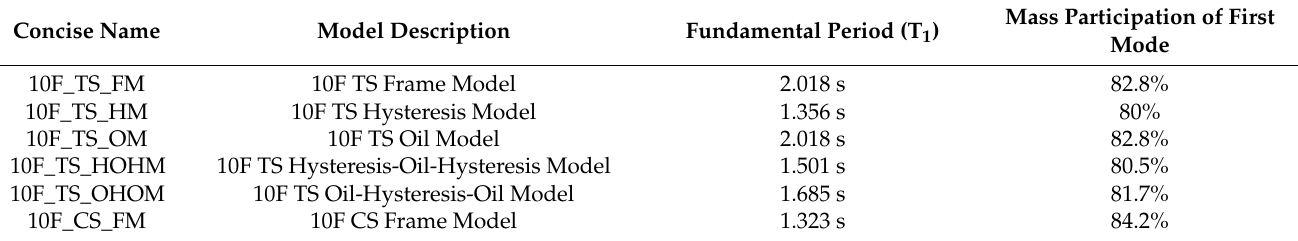
Table 1. Description of building models with different damper arrangements.